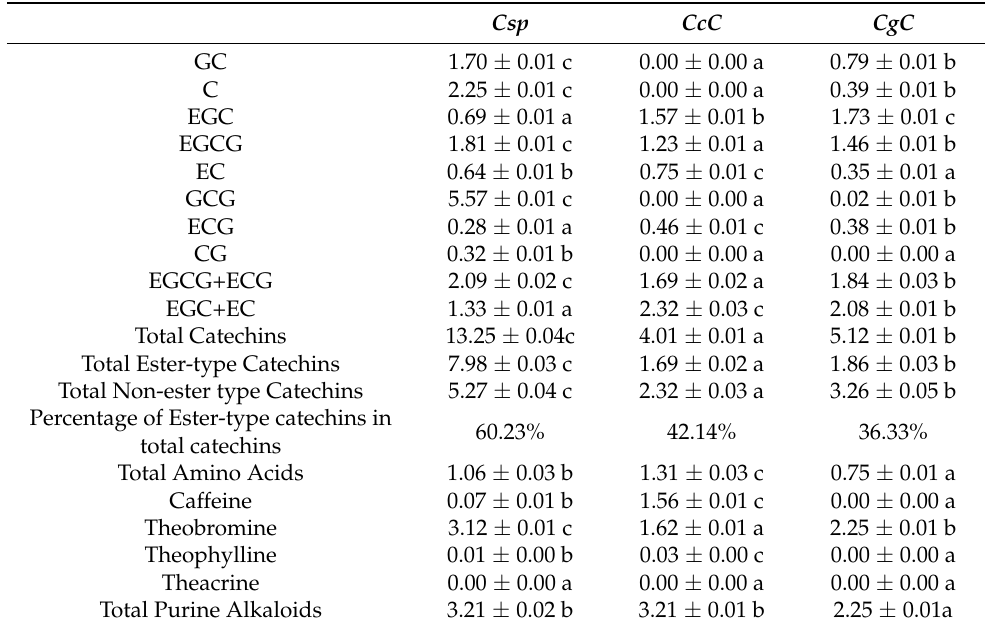
Table 6. Contents of catechins, purine alkaloids and total amino acids in three green tea products from three Camellia